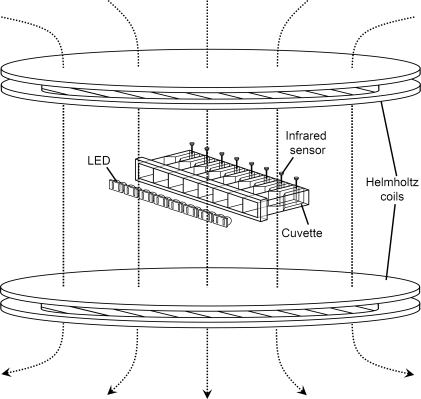
Schematic Representation of the Experimental ApparatusThe locomotor recording device was described in detail previously [59,60]. Here eight of 32 spectrophotometer cuvettes are shown as representative “houses” for flies. Two monochromatic LEDs were placed in front of each cuvette, and the flies were illuminated homogenously in the cuvettes. Helmholtz coils were placed above and below the recording device, generating a static magnetic field (dotted light with arrows) perpendicular to the plane of the recording device. The infrared sensors for monitoring the activity of the flies were on the ends of the cuvettes opposite the LED illumination.